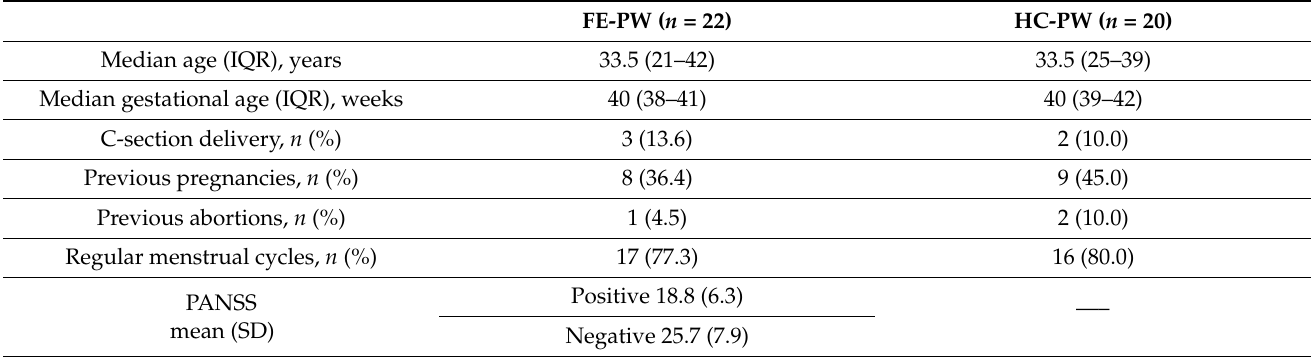
Table 1. Clinical and demographic characteristics of women with a first-psychotic episode during pregnancy and in the healthy controls. FE-PW = first-psychotic episode during pregnancy. HC-PW = healthy controls pregnant